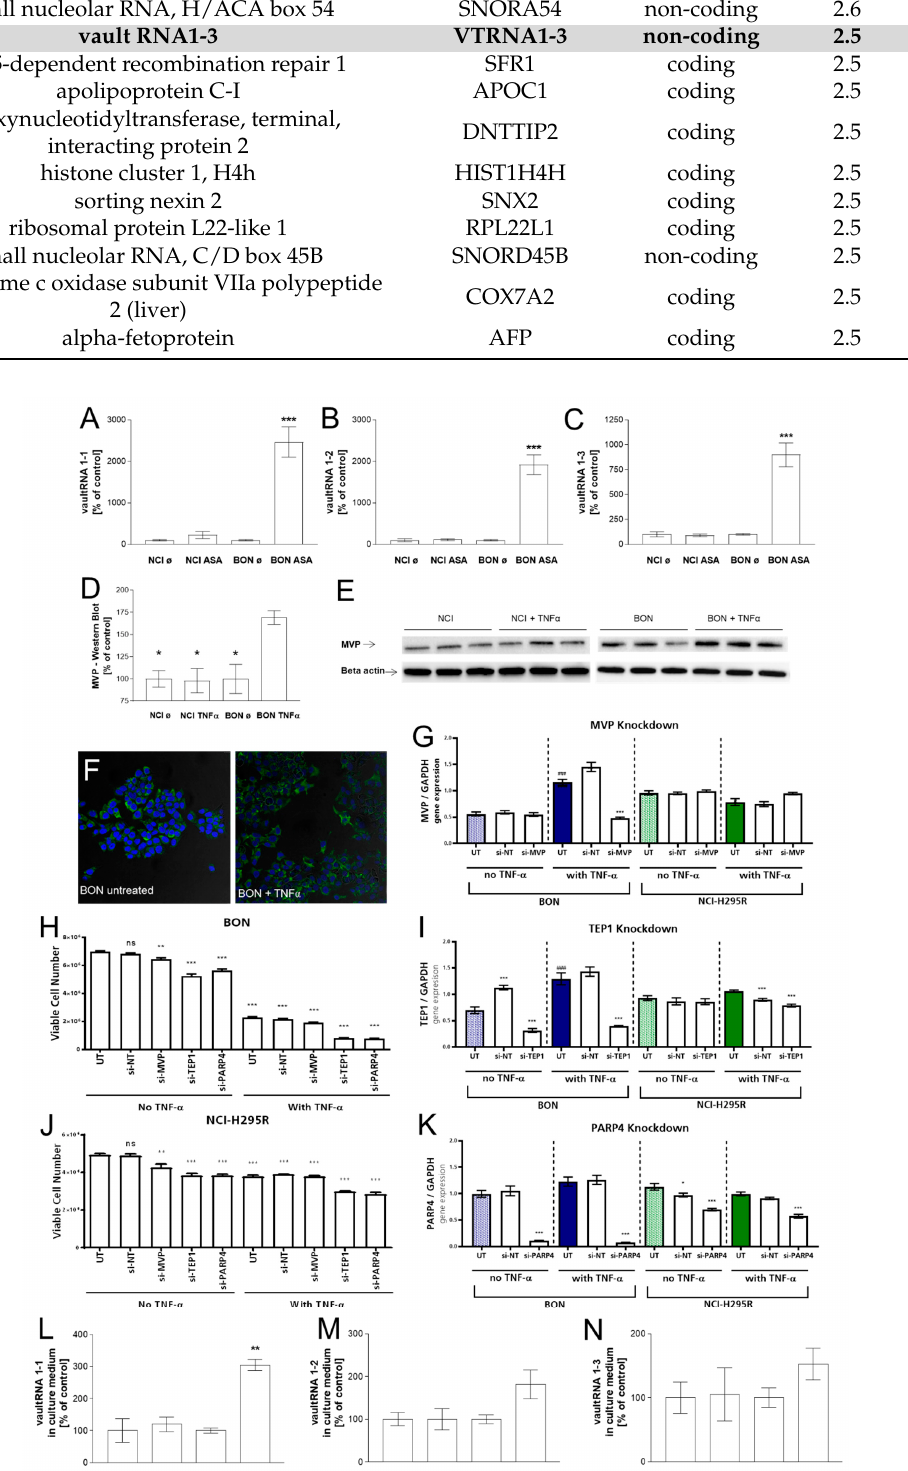
Figure 2. Vault RNA1-1 ( A ), 1-2 ( B ), and 1-3 ( C ) real-time PCR analysis of NaCl- and ASA404-treated BON and NCI-H295R tumors. MVP western blot ( D , E ) and MVP immuno-fluorescence ( F ) of TNF α - stimulated BON and NCI-H295R tumor cells. MVP, TEP-1, and PARP4 gene expression analysis ( G, I,K ) and cell viabilities ( H,J ) under TNF α stimulation and specific si-RNA knockdown. Vault RNA levels in cell culture supernatants of TNF α -stimulated BON and NCI-H295R tumor cells ( L – N ). The